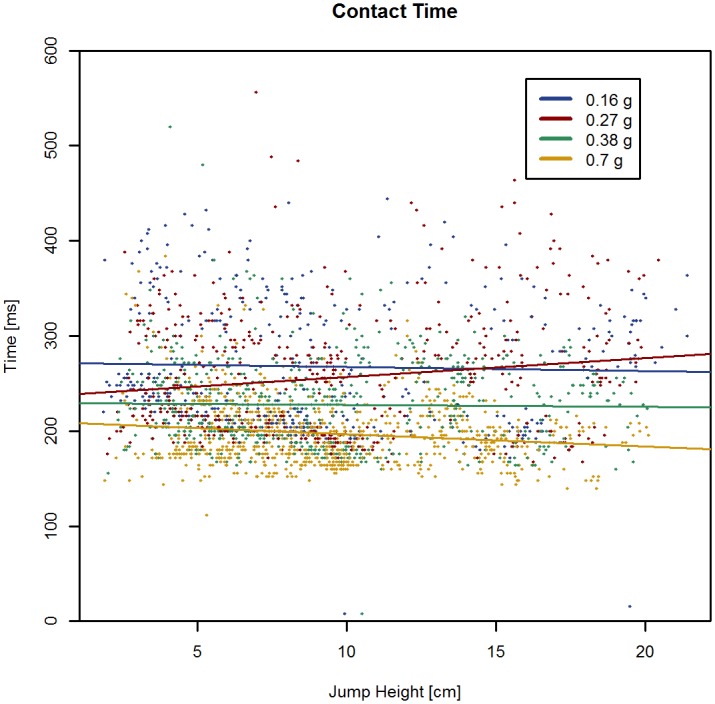
Contact time (Tc).Composite Tc signals of all hopping trials are depicted. Contact time decreased significantly with increasing gravity levels (P < 0.001) while jump heights (height of flight) had no effect on contact time.